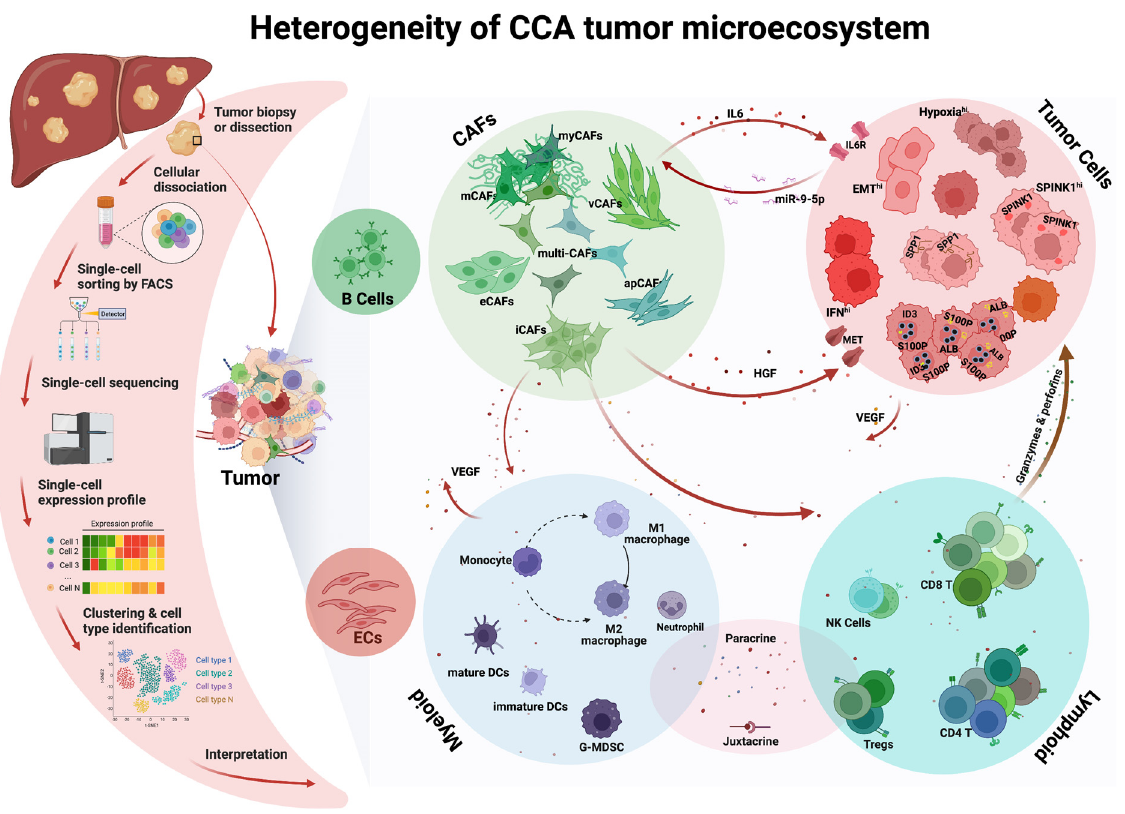
Figure 1. Heterogeneity of tumor ecosystem in cholangiocarcinoma defined through single cell RNA sequencing analysis. An illustration of single-cell RNA sequencing technology and heterogeneity of tumor ecosystem in cholangiocarcinoma (created with BioRender.com, accessed on 11 January2023).